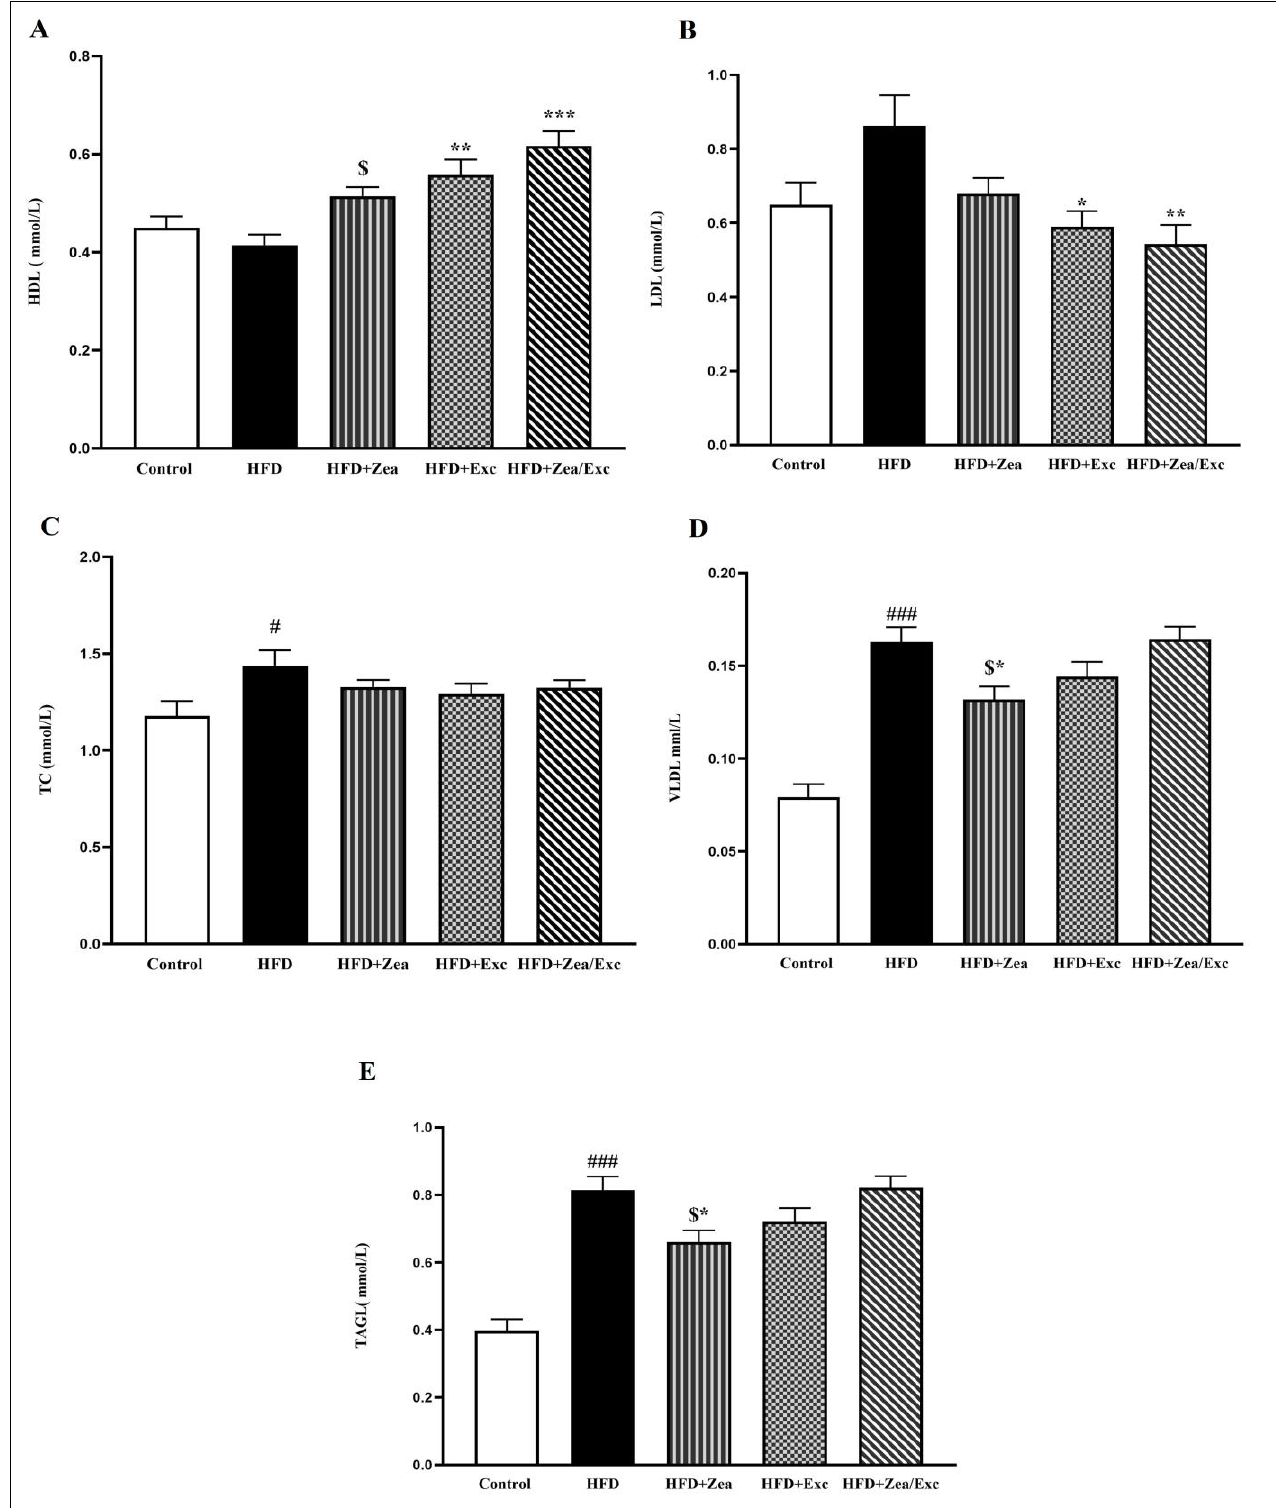
Figure 4. Effects of Zea and Exc on the serum lipid profiles in HFD-induced obese rats. ( A ) High- density lipoprotein (HDL); ( B ) low-density lipoprotein (LDL); ( C ) total cholesterol (TC); ( D ) very low density lipoprotein (VLDL); ( E ) triacylglycerol (TAG). Data are expressed as means ± SEM, n = 12. # p < 0.05, ### p < 0.001 vs. control; * p < 0.05, ** p < 0.01, *** p < 0.001 vs. HFD; $ p < 0.05 vs. HFD + Zea/Ex.